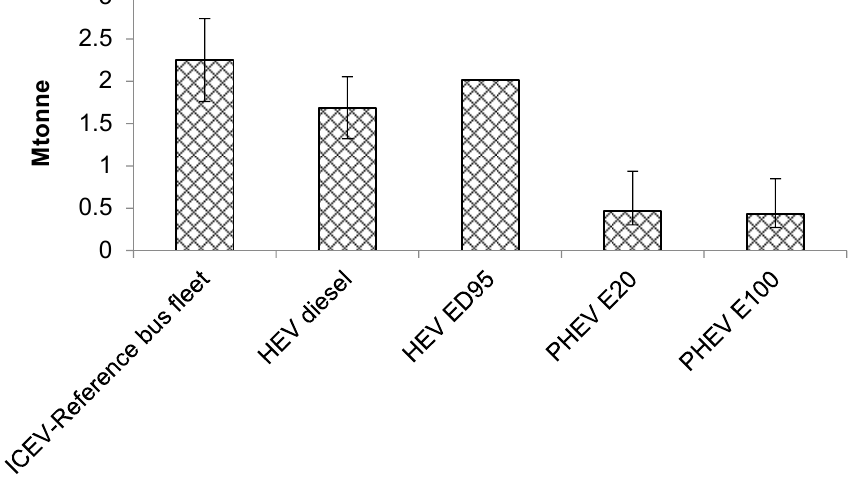
Figure 6. TTW CO 2 emissions for the Ecuadorian bus fleet in millions ton/year, with uncertainty (range based with uniform distribution).